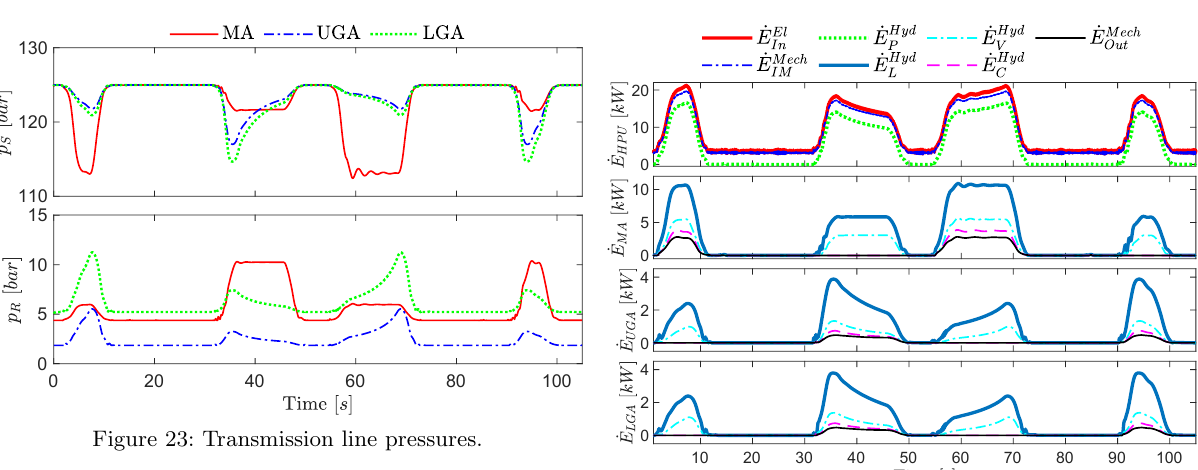
Figure 25: Power consumption of hydraulic power unit, main arm, upper guide arm, and lower guide